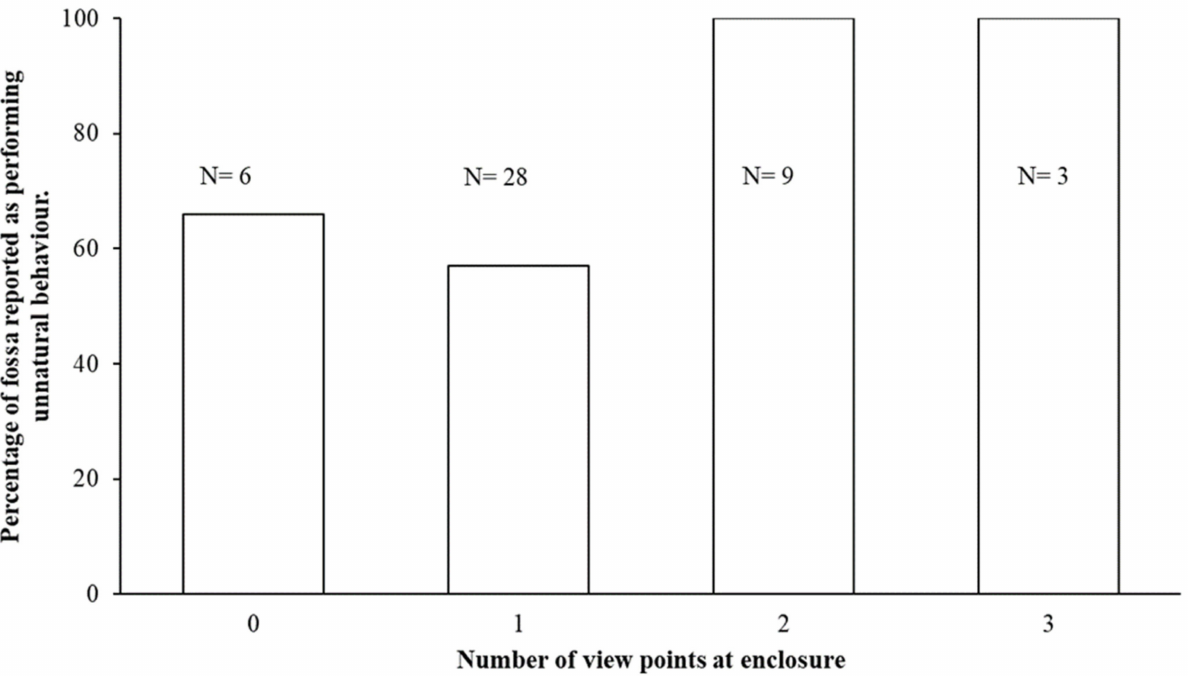
Figure 4. Percentage of observations of unnatural behaviour compared to the number of public view points at each fossa’s enclosure.